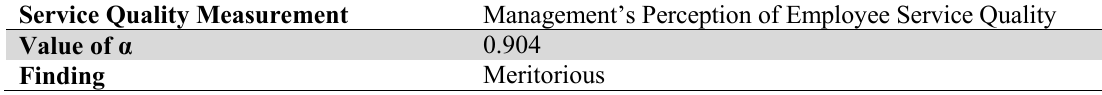
Reliability Analysis of Employees’ Service Quality scale (22 items) Service Quality